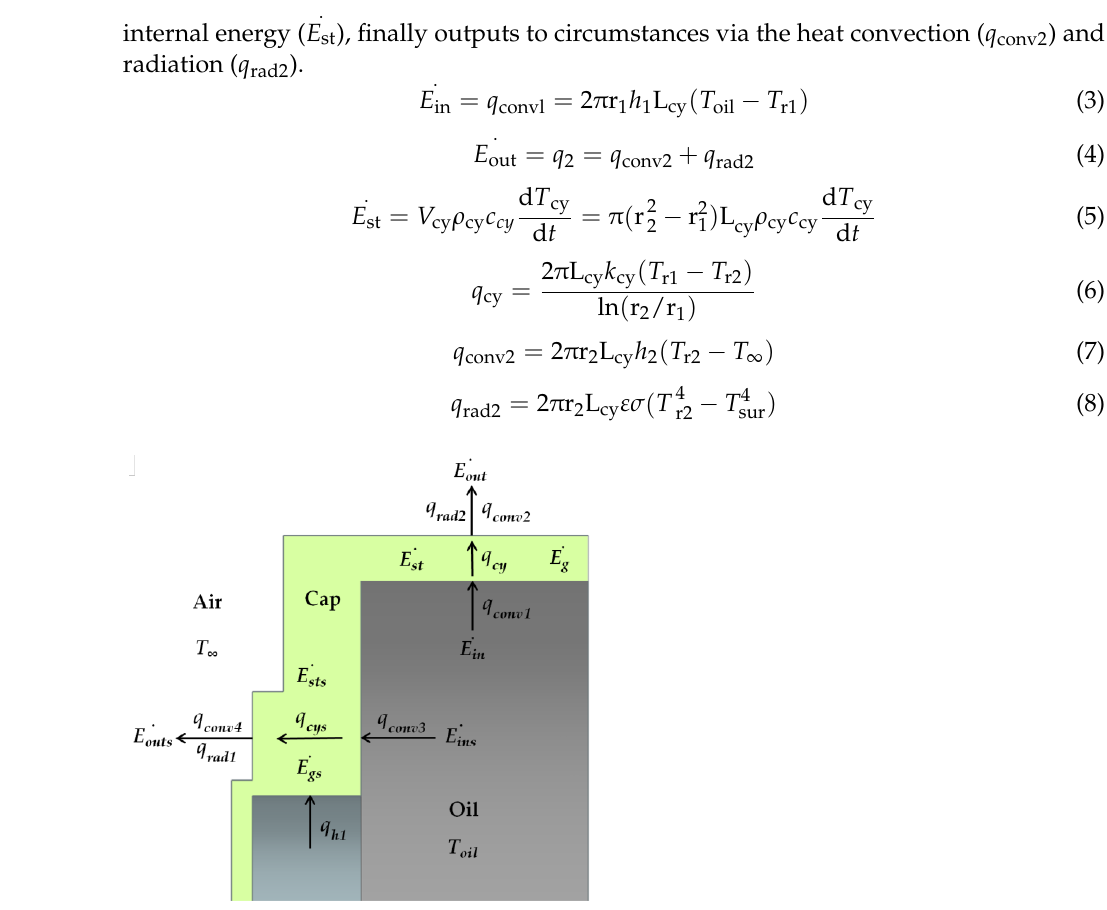
Figure 5. Schematic configuration of heat transfer of the pump cap. According to the experimental correlation formula for natural convection heat transfer of a horizontal cylinder with a wide range of Rayleigh numbers recommended by Churchill and Chu [28], the Nusselt number of the cylinder outer-face is given in Relation (9). Thus, the convective heat transfer coefficient h 2 could be calculated in Equation